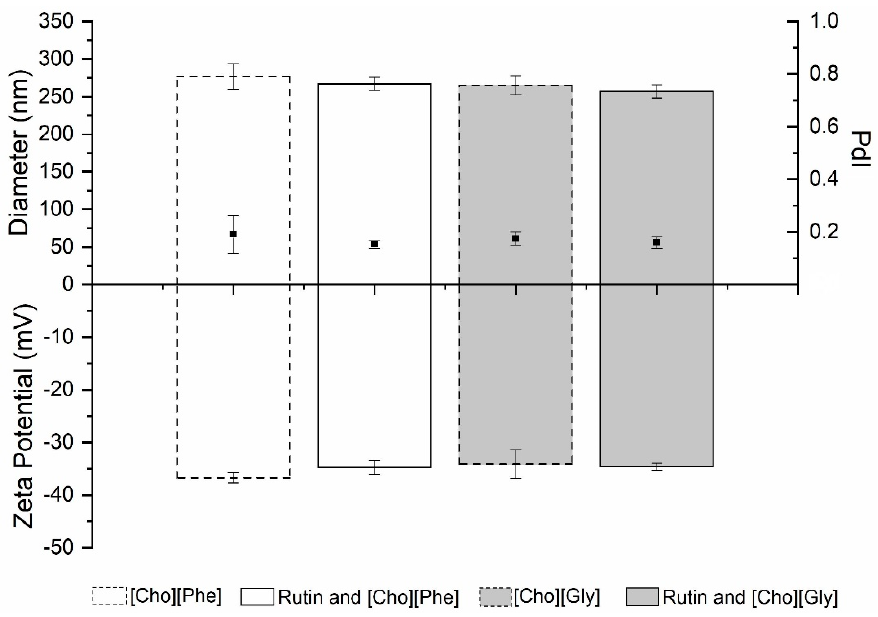
Figure 5. Diameter (nm) (top bars), PdI (black squares) and zeta potential (mV) (bottom bars) of unloaded and rutin ‐ loaded IL ‐ PLGA nanoparticle hybrid systems ( n = 3, mean SD).